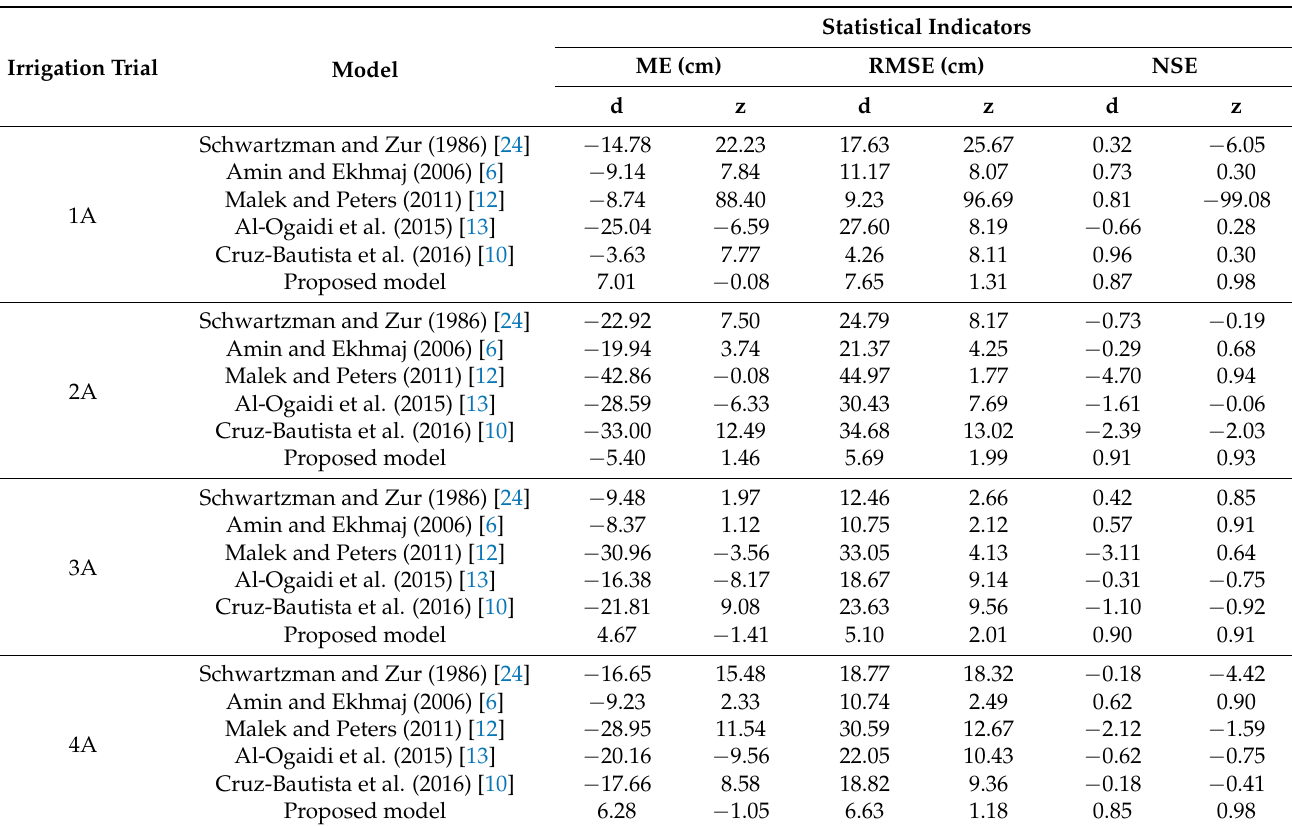
Table 6. Statistical indicators of the empirical models for the first irrigation block for the width (d) and depth of the wetting front (z).